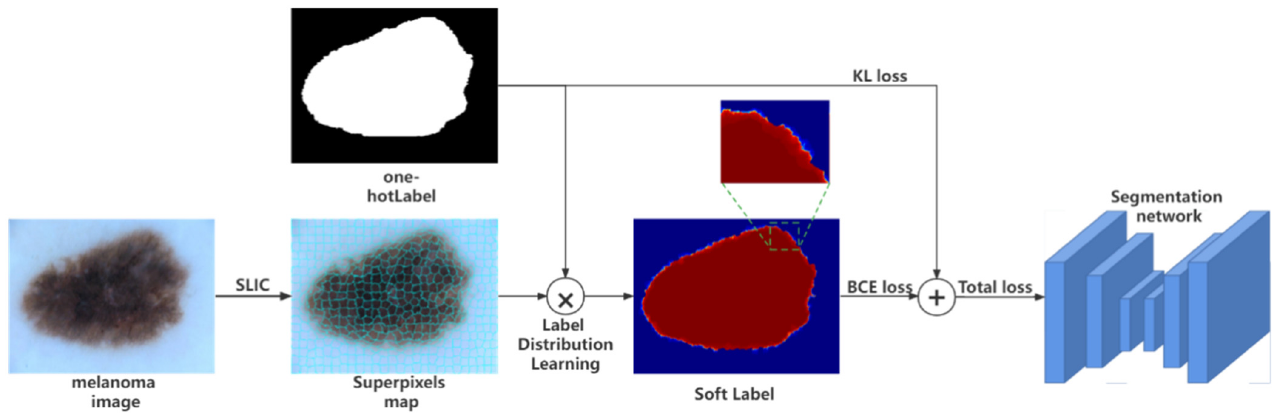
Figure 2. Structure of our proposed method.